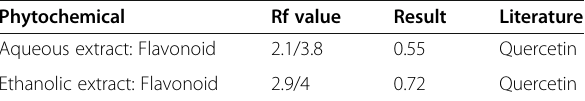
Table 4 Thin layer chromatography of standard and aqueous and ethanolic extracts Phytochemical